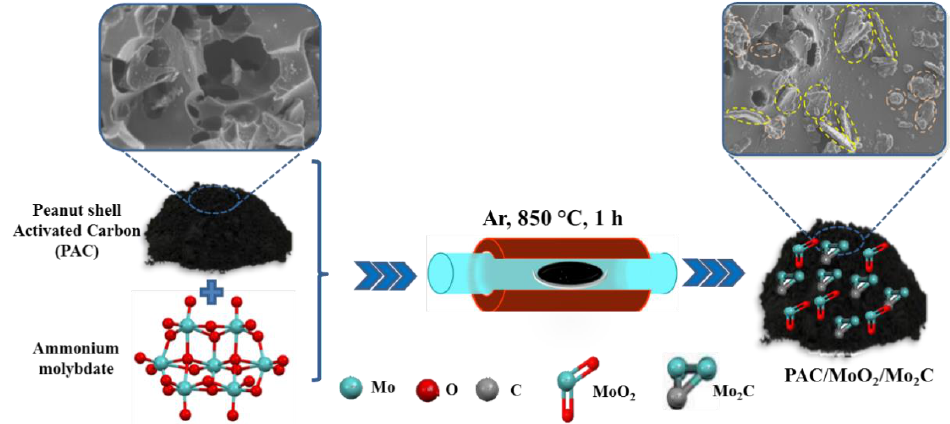
Figure 1. Schematic illustration for the synthesis method of the PAC/MoO 2 /Mo 2 C ternary compo- sites